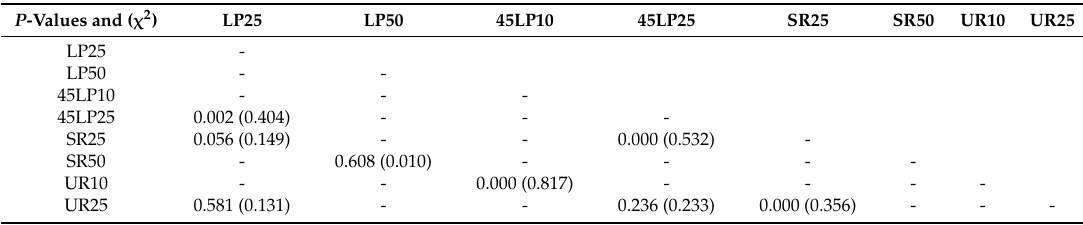
Table A4. P -values and ( χ 2 ) for normalized absolute values of sagittal moments over all subjects—was not analysed.